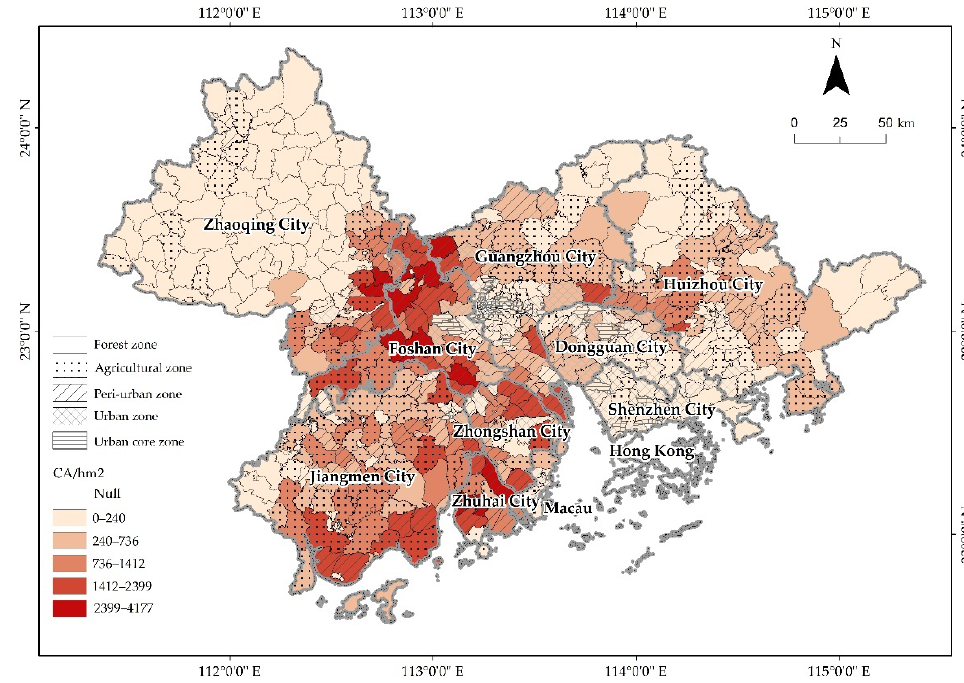
Figure 6. Spatial variation in pond total area (CA) across the urban-rural gradient (urban core to forest) in the PRD.